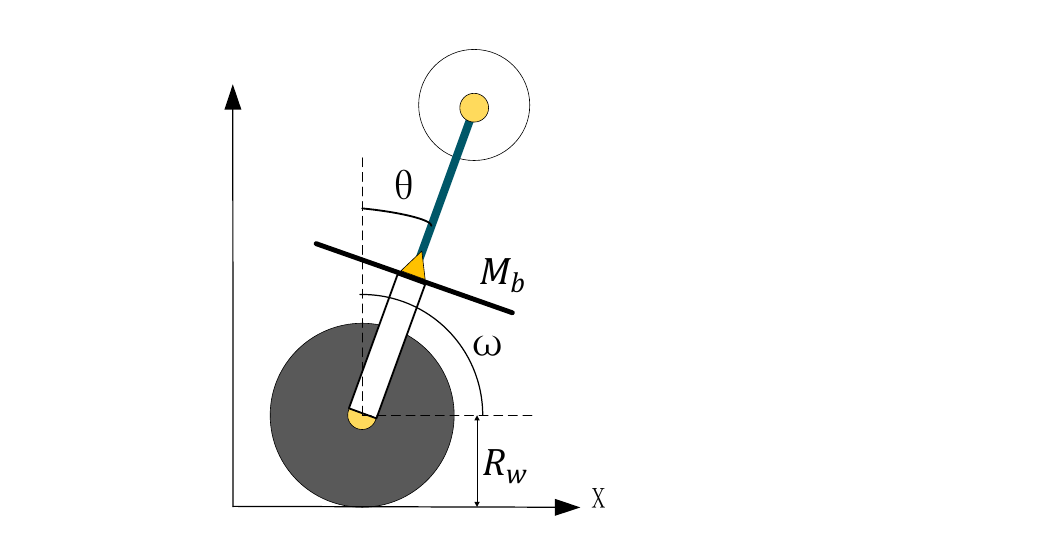
Figure 2. Longitudinal model of the unicycle robot.